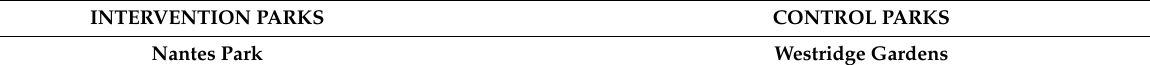
Table 2. Park features in each